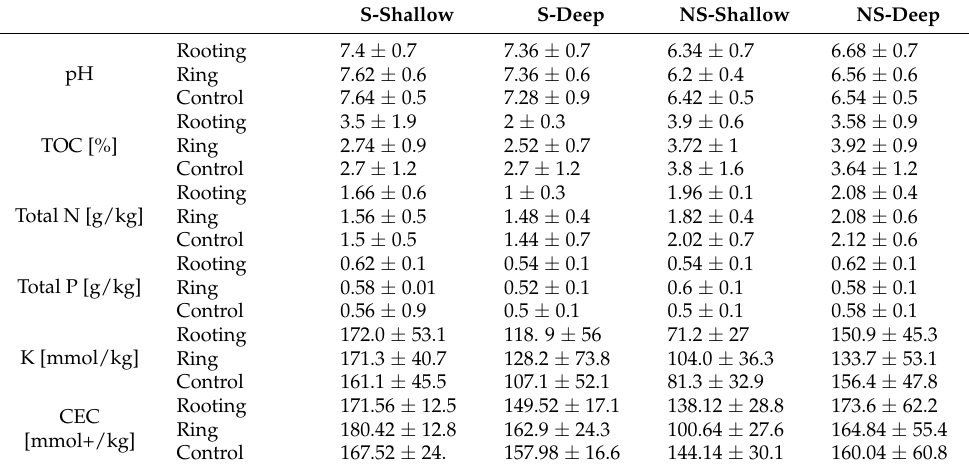
Table 3. Mean and standard deviation of soil parameters measured by the NIR device in sedimented (S) vs. non-sedimented (NS) soil, in the rooting, ring, and control areas in case of shallow and deep rooting.